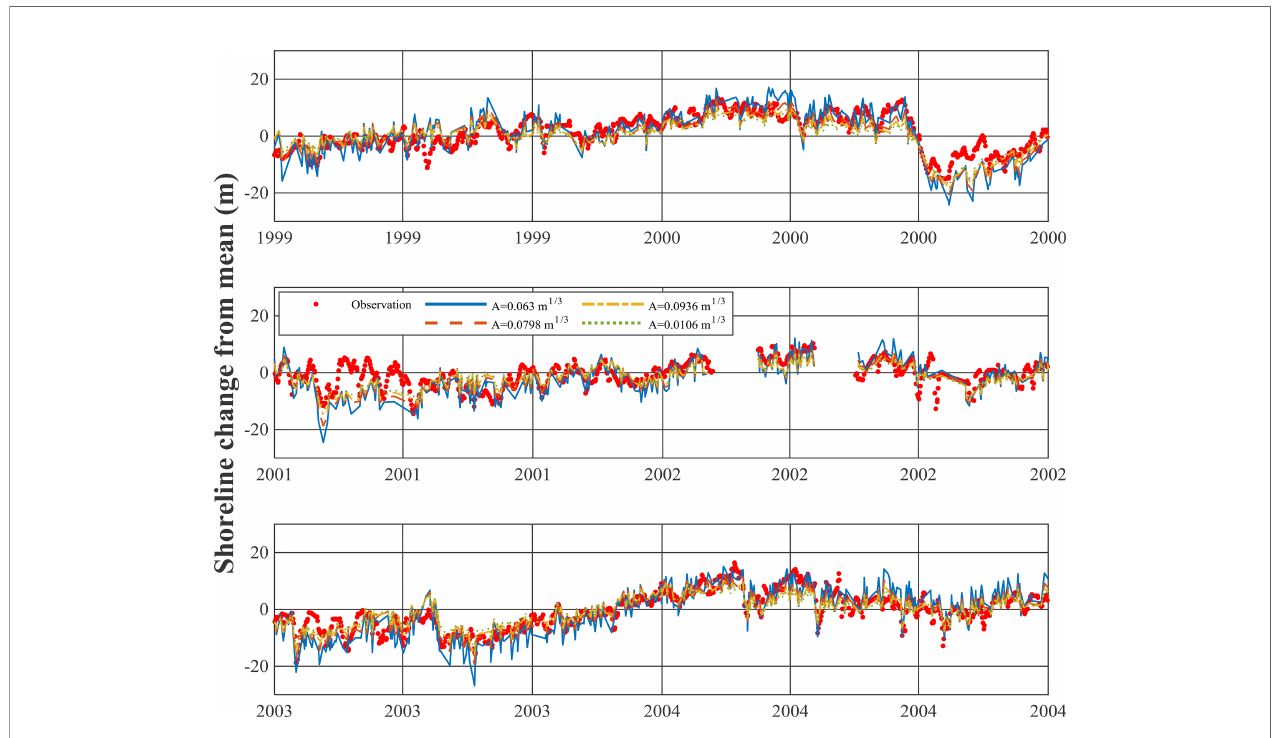
FIGURE 8 | Model outputs compared to observations (red dot) for 4 different values of A